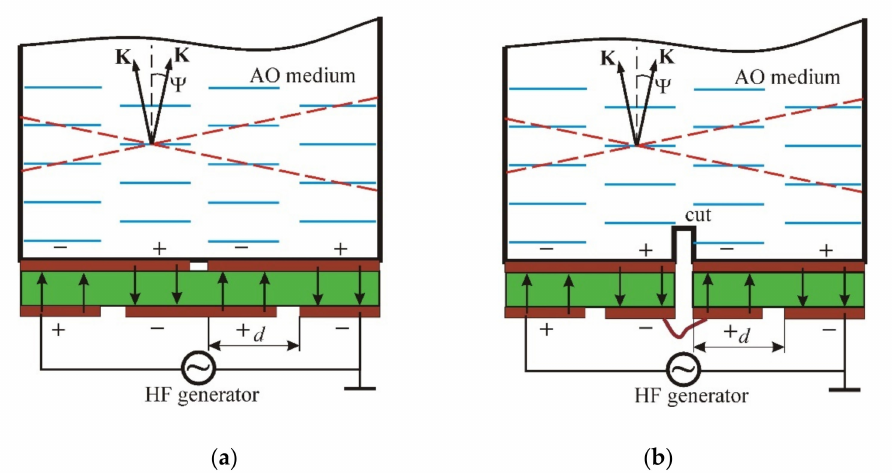
Figure 1. Two variants of flat phased-array transducers with antiphase excitation of adjacent sec- tions: ( a ) Sectioning by partitioning the internal and external electrodes; ( b ) Sectioning by means of transducer